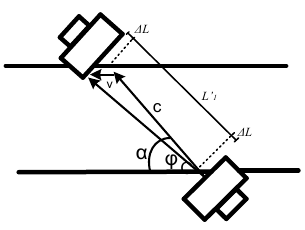
Figure 5. Ultrasonic beam deviation.